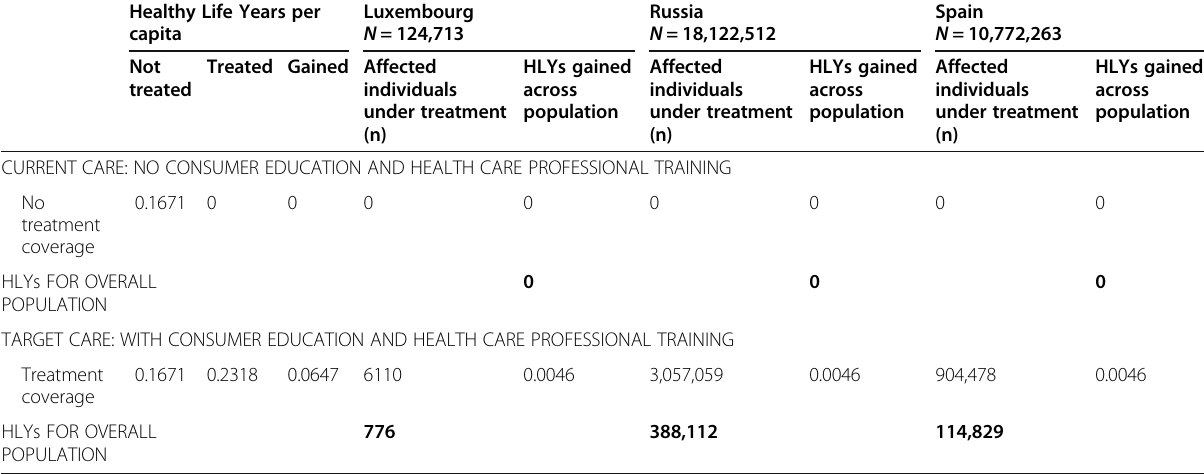
Table 11 Healthy Life Years (HLYs) potentially gained in 1 year by each element of the proposed intervention (MOH) Healthy Life Years per